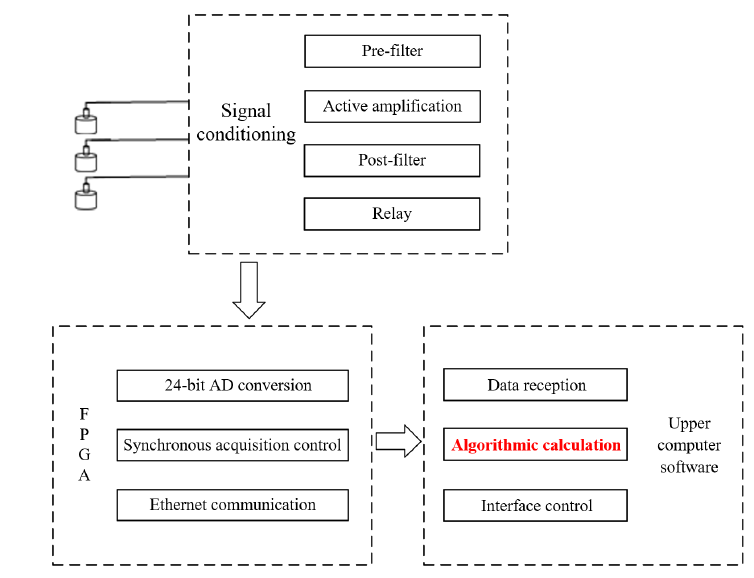
Figure 2. Micro − vibration measurement system.